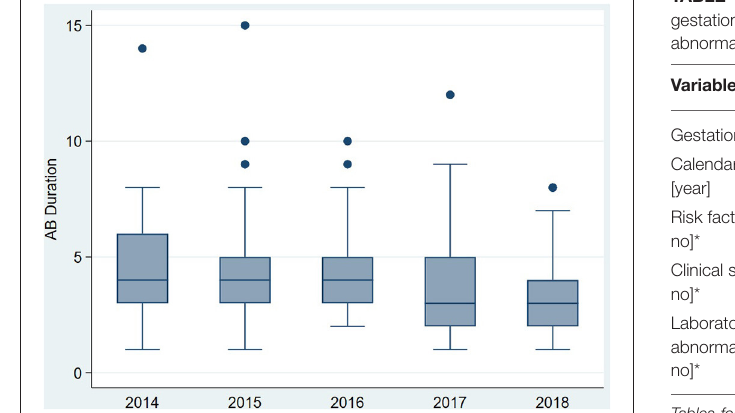
FIGURE 1 | Primary outcome: duration of antibiotic therapy (median) for term and late-preterm infants above 34 0/7 weeks of gestational age from 2014 to 2018.